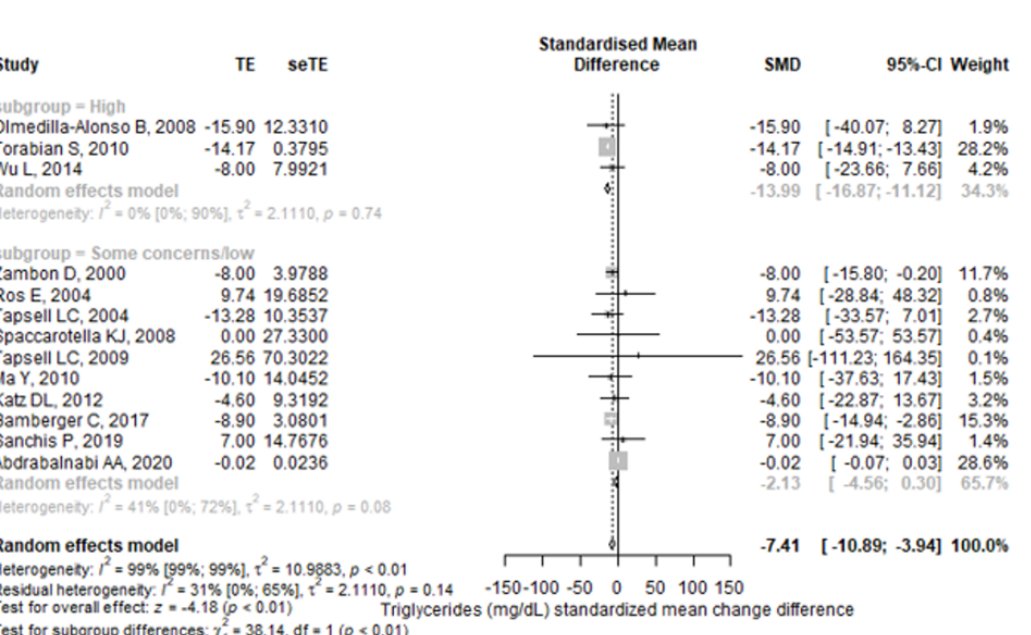
Figure 4. Forest plot for total cholesterol (mg/dL) standardized mean change difference. TE — treat- ment effect; seTE — the standard error of the treatment effect; SMD — standardized mean difference; CI — confidence interval. Similarly, the meta-analyzed SMD displayed a significantly greater reduction in LDL-C concentrations with the walnut diets than with the control diets (SMD = − 5.93; 95% CI: − 7.77 –− 4.09, p < 0.001) (Figure 5), but without significant heterogeneity (I 2 = 24.8%; 95% CI: 0 – 61.8%, p -heterogeneity = 0.2).